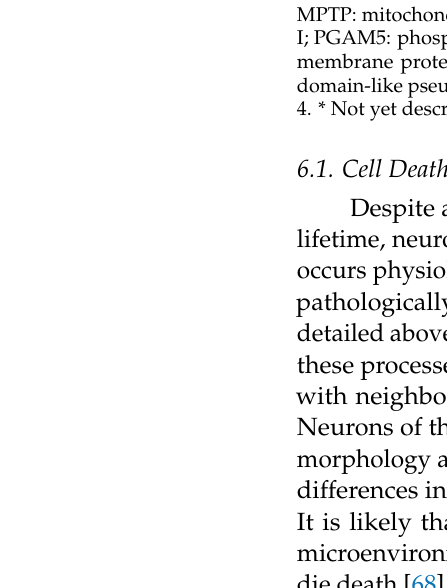
Table Abbreviations: MOMP: outer mitochondrial membrane permeabilisation; ROS: reactive oxygen species; MPTP: mitochondrial permeability transition pore; KEAP1: Kelch-like ECH-associated protein 1; CASP: